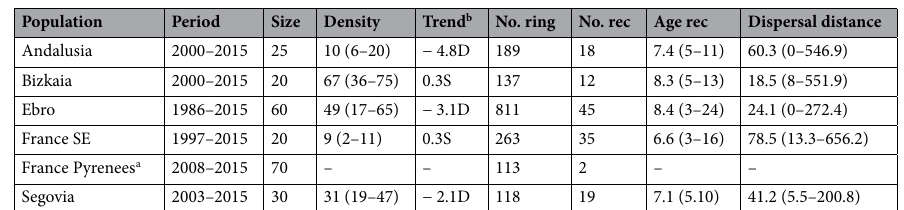
Table 3. Description of the six study populations of Spain and France. The study period, the size (approximate no. of breeding pairs), the density (median and range of the number of breeding pairs in a buffer of median natal dispersal distance around the natal nest), the annual percentage of growth rate (D and S denote declining and stable populations, respectively), the number of fledglings ringed during the study period (No. ring), the number of fledglings recruited as first-time breeders (No. rec.), age at recruitment (Age rec, mean and range, in years), and the dispersal distance (median and range, in kilometres) are shown. Note that only birds ringed until 2015 were considered, as our study finalized in 2018 and the youngest birds recruited when 3-year old. a The few birds recruited as breeders were not sexed, so these birds were excluded from the analyses. b The annual percentage of growth rate was calculated as (( N t / N 0 ) 1 /( t − t 0 ) − 1 ) × 100 , where N population sizes at times t0 and t ,